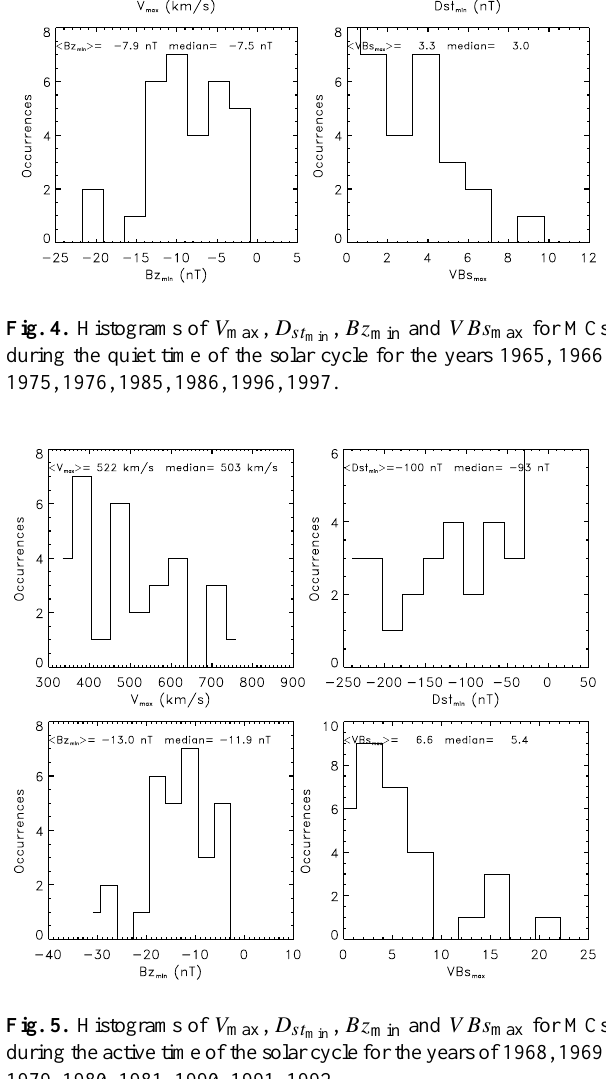
, Bz min and V Bs max for min